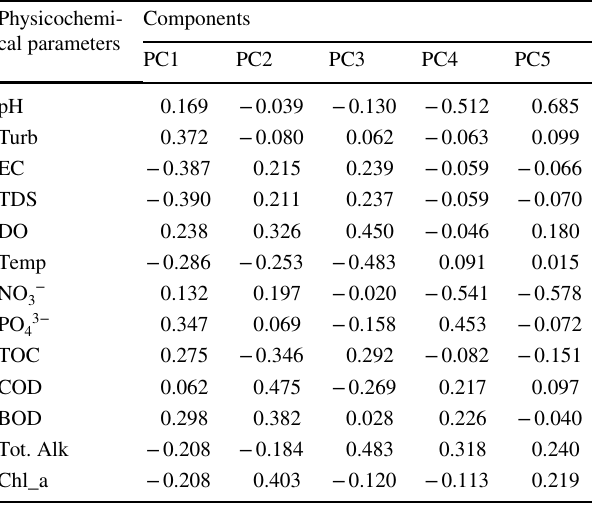
Table 2 Loadings of the variables and correlation between variables and the PC scores Physicochemi- Components cal parameters